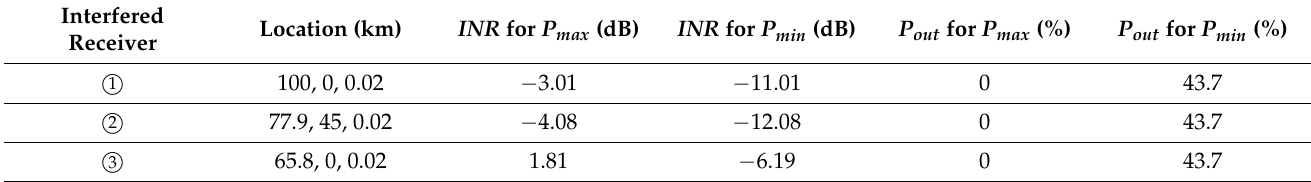
Figure 8. ( a ) SINR map for 𝑷 (cid:3040)(cid:3028)(cid:3051) ; ( b ) SINR map for 𝑷 (cid:3040)(cid:3036)(cid:3041) . Table 3. INR and P out for the interfered receiver locations. Table 3. 𝐼𝑁𝑅 and 𝑃 (cid:3042)(cid:3048)(cid:3047) for the interfered receiver locations.